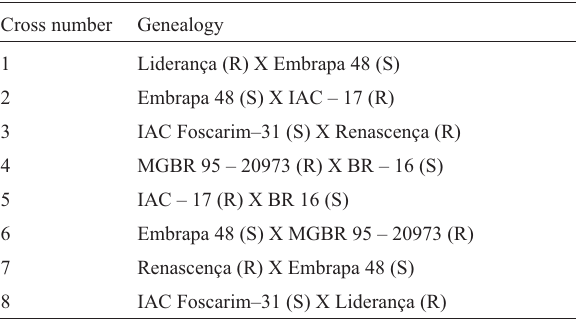
Table I - Genealogy of the crosses used to study resistance to powdery mildew in